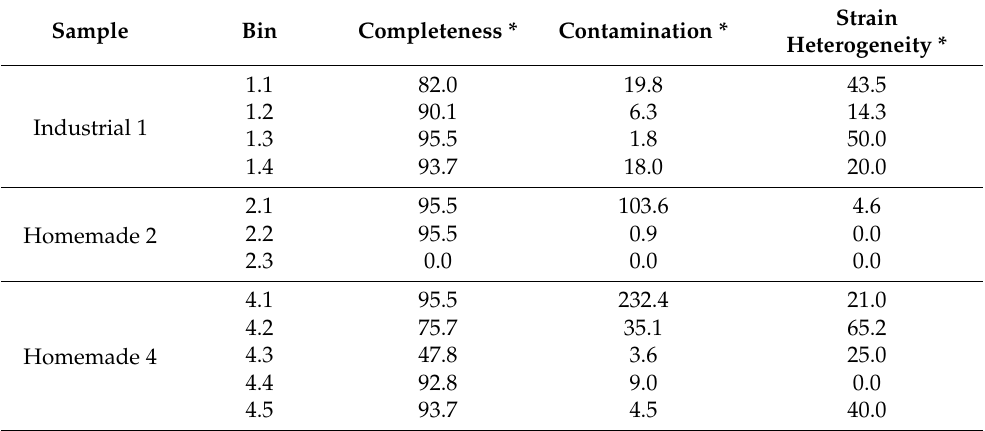
Table 2. Quality of bins obtained from shotgun metagenomics of the selected Feta cheese samples.